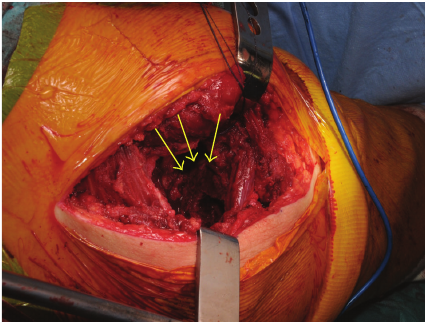
Figure 5: Photograph taken after removal of the right femoral head. The bony substance of the femoral trochanter was poor and the medullary cavity of the proximal femur was expanded (arrows).